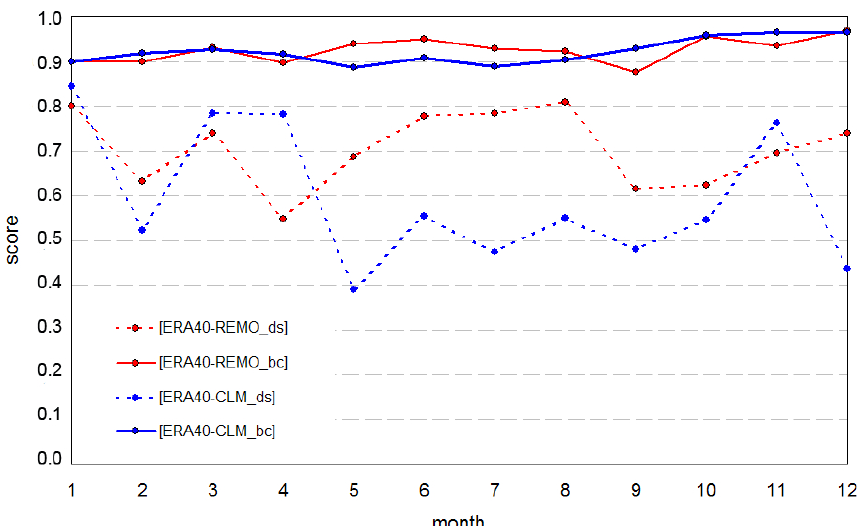
Figure 2. Monthly Perkins scores for regionalised and bias-corrected (linear-scaling) mean air temperature for two ERA40-driven model runs (CLM 2.4.6 and REMO 5.7) for the time period 1961–1990. Dashed lines indicate uncorrected regionalised model runs (ds), solid lines represent regionalised and bias corrected (bc)